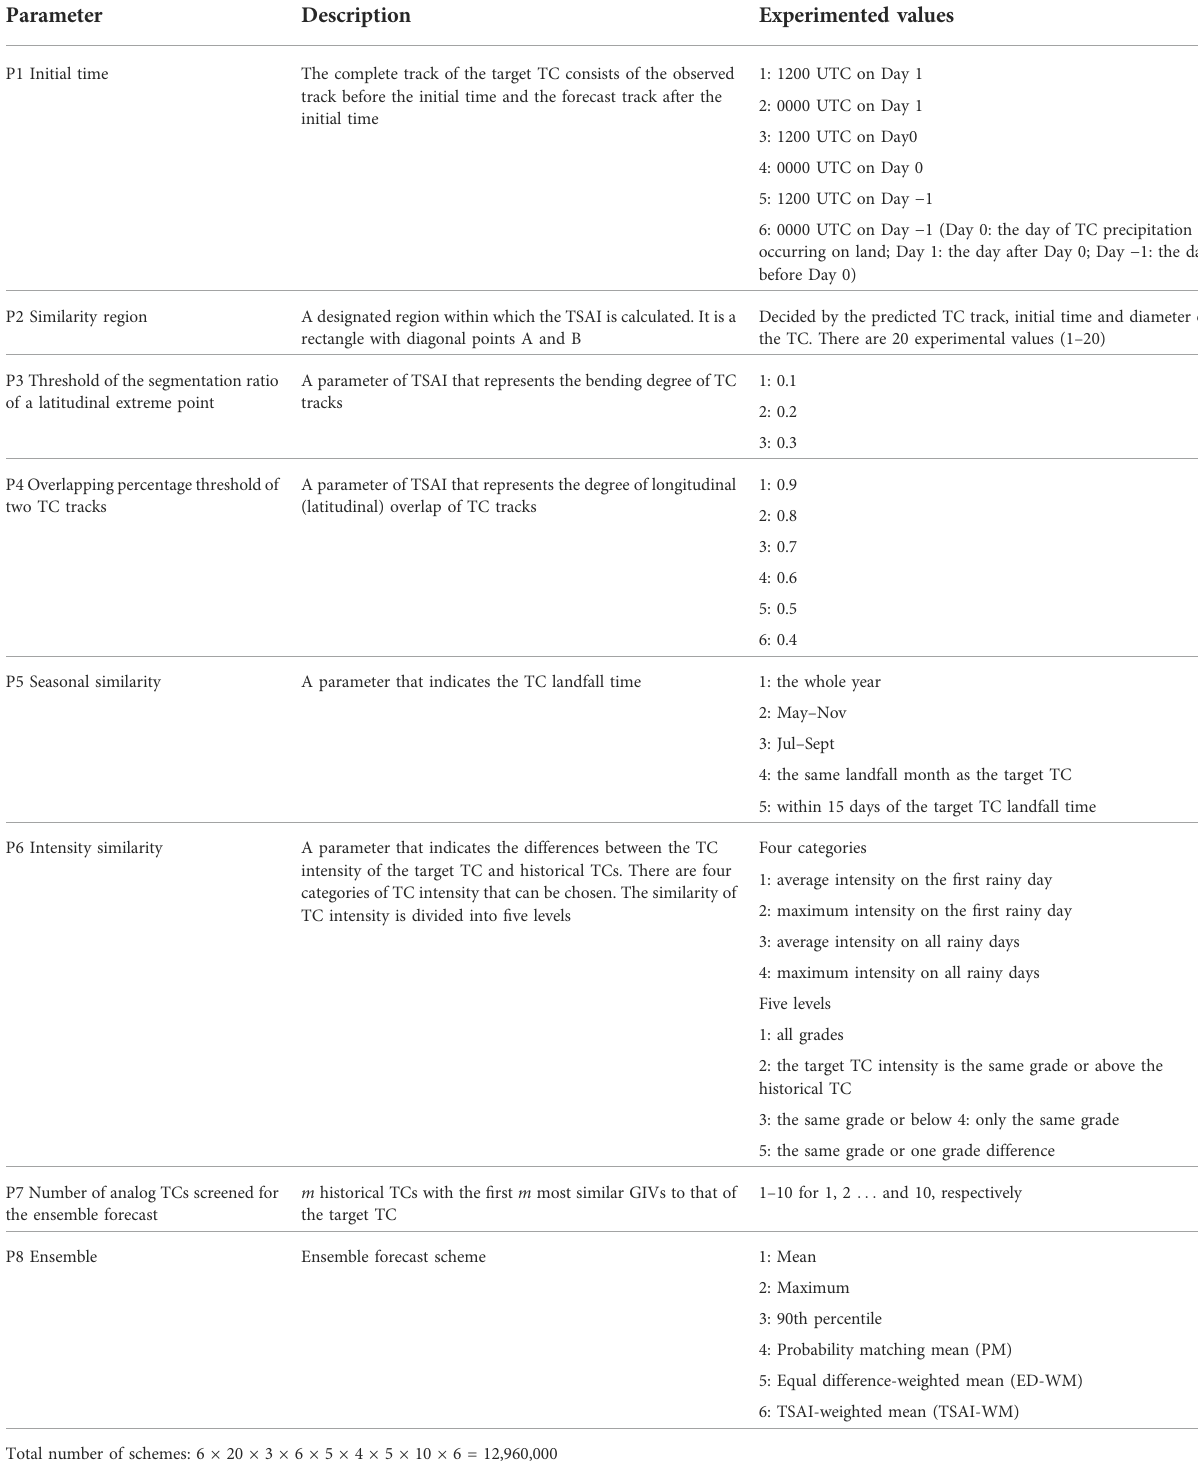
TABLE 1 Parameters of the DSAEF_LTP